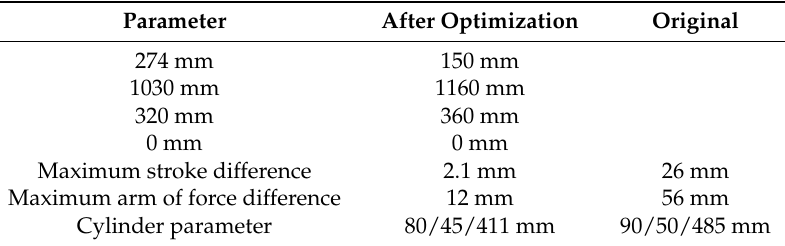
Table 1. The coordinates of articulated points optimized by GA.